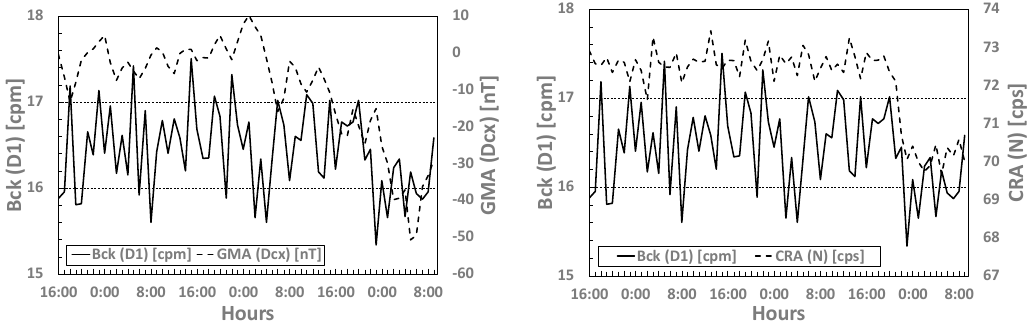
Figure 3. Background data (D1), geomagnetic activity (GMA) (Dcx) (left panel) and cosmic-ray activity (CRA) (N) (right panel) between 2014 December 19 and 2014 December 22. Dcx stands for the Dcx index and N for the neutron counts. Table 1. Correlation between the three variables background (D1), GMA (Dcx) and CRA (N), using covariance (Equation